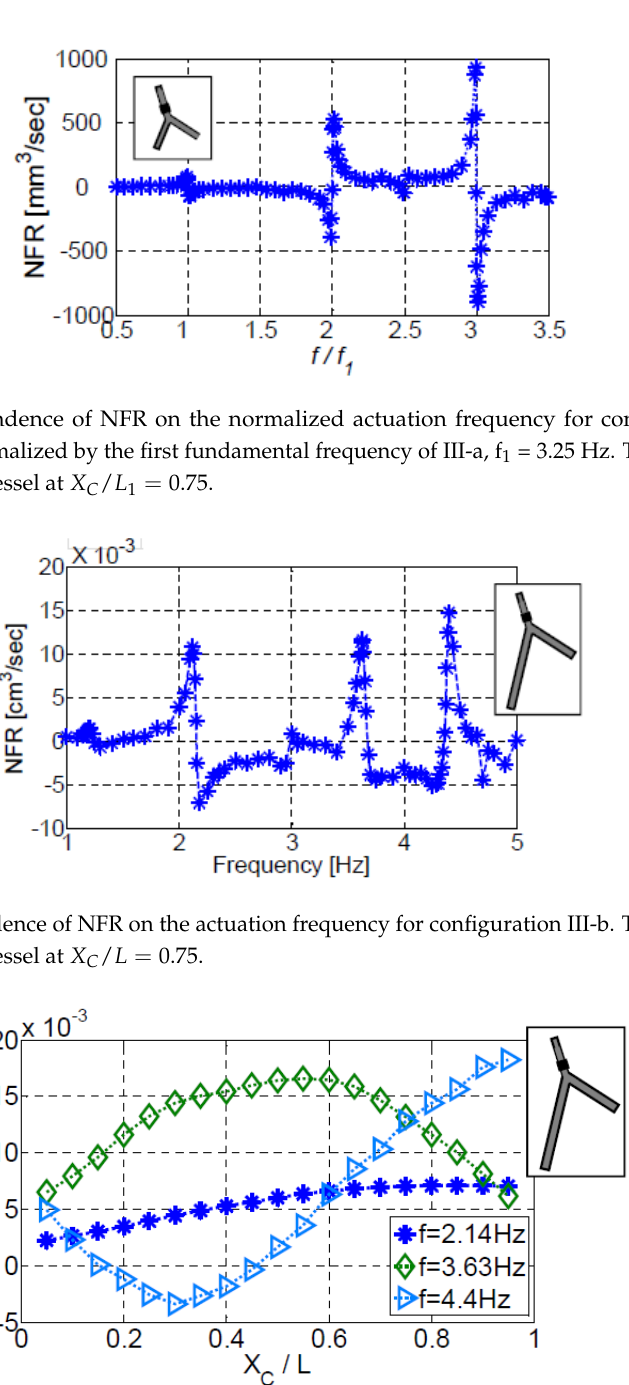
Figure 8. The dependence of NFR on the actuator duty cycle for configuration III-b. The actuator was located on the first vessel at . Actuation frequency was 4.4 Hz, close to the fourth natural frequency of the system.